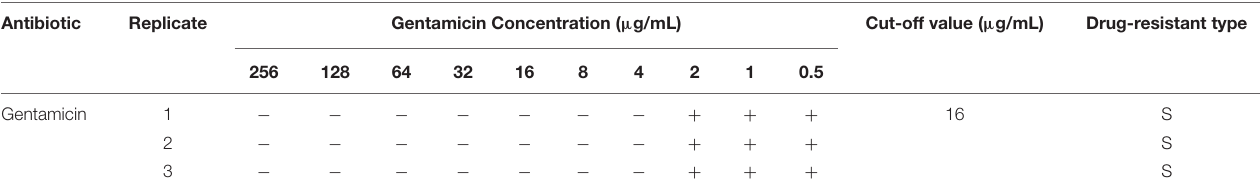
TABLE 1 | The MIC ( µ g/mL) of L. plantarum ATCC14917 to gentamicin prior to the evolution experiment. Antibiotic